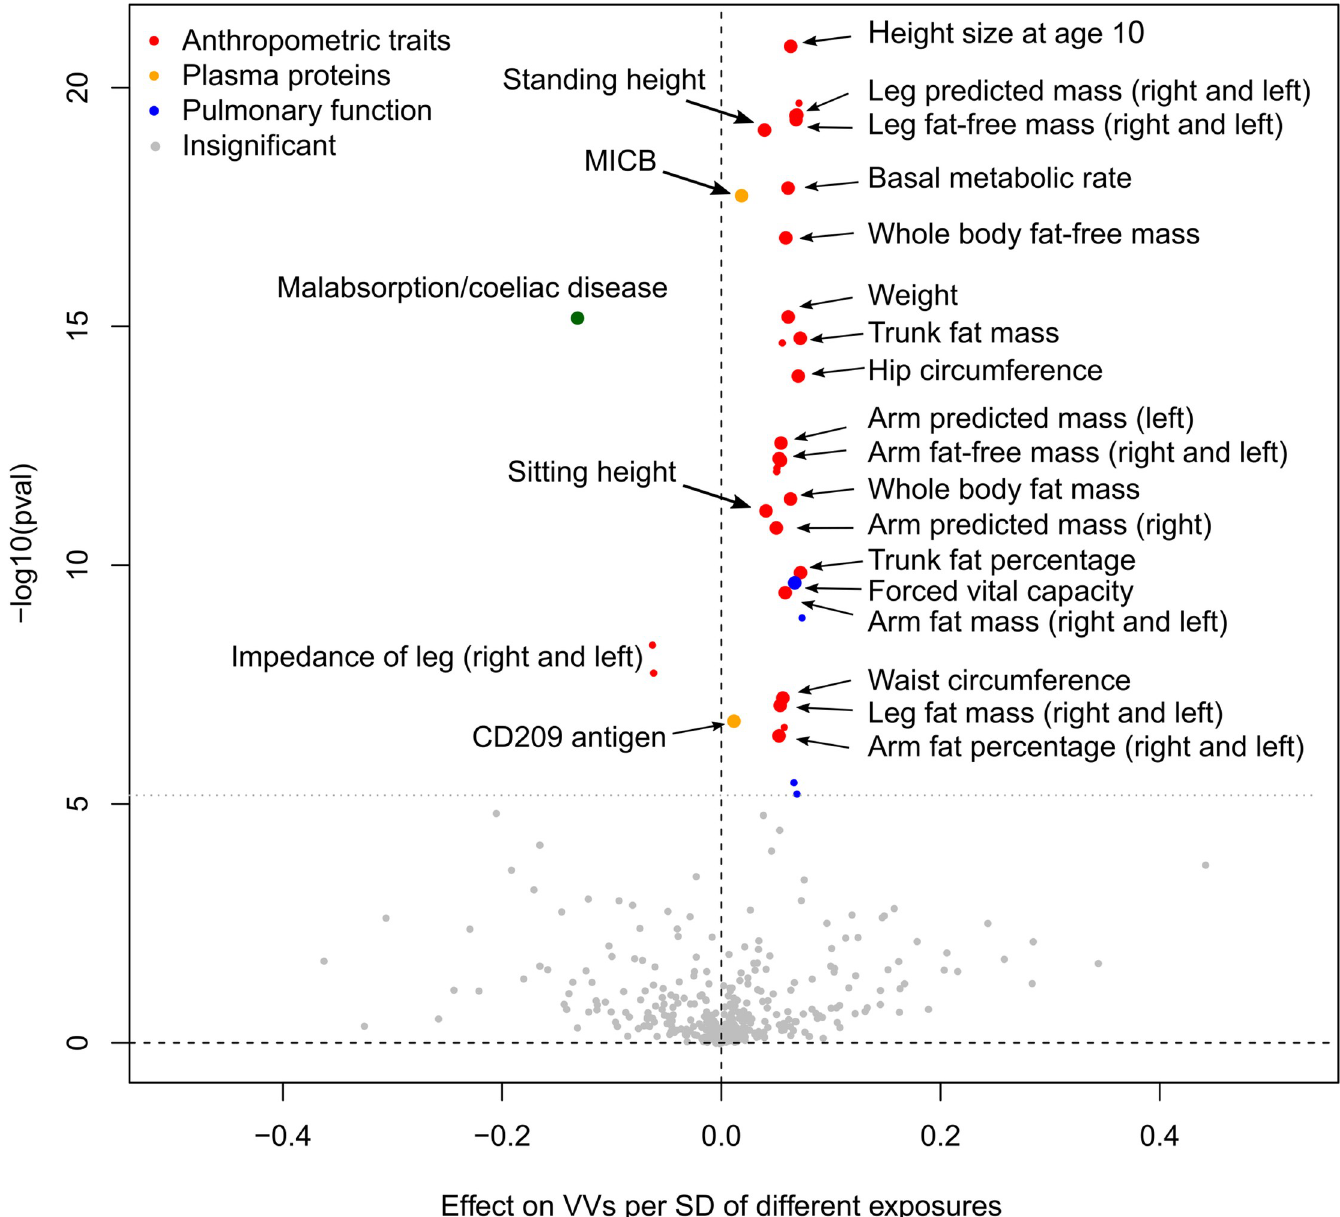
Fig 5. Volcano plot depicting the results of hypothesis-free 2SMR analysis (IVW approach). The x-axis shows 2SMR beta, and the y-axis denotes the level of statistical significance on a logarithmic scale. Grey color indicates the traits that did not pass either 2SMR, or the Steiger test, or additional robustness analysis. Small colored circles depict the traits that passed these tests, but either exhibited heterogeneity in causal effects amongst instruments after removing potential outlier SNPs or did not passed 2SMR after this procedure. Large colored circles represent the traits that both passed 2SMR and showed no heterogeneity after the outliers removal (“the most reliable traits”). 2SMR coefficients are shown as calculated before the correction for pleiotropy. “Pulmonary function” traits include different estimates of forced vital capacity and forced expiratory volume in 1-second. Further details are provided in S13 Table. MICB, MHC class I polypeptide-related sequence